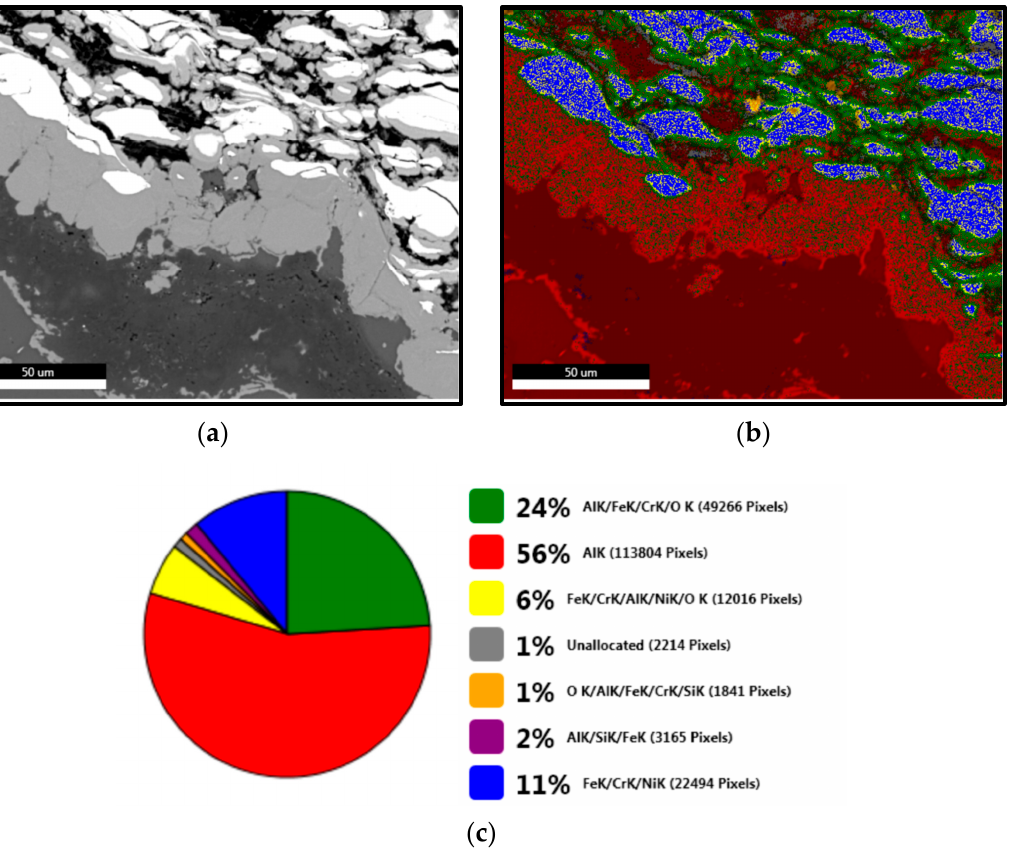
Figure 14. SEM micrograph and EDS of AISI304-(Al + 50%ZrO 2 ) 12-layer TBC: ( a ) SEM image; ( b ) EDS map of element distribution; ( c ) result of elemental analysis by EDS.